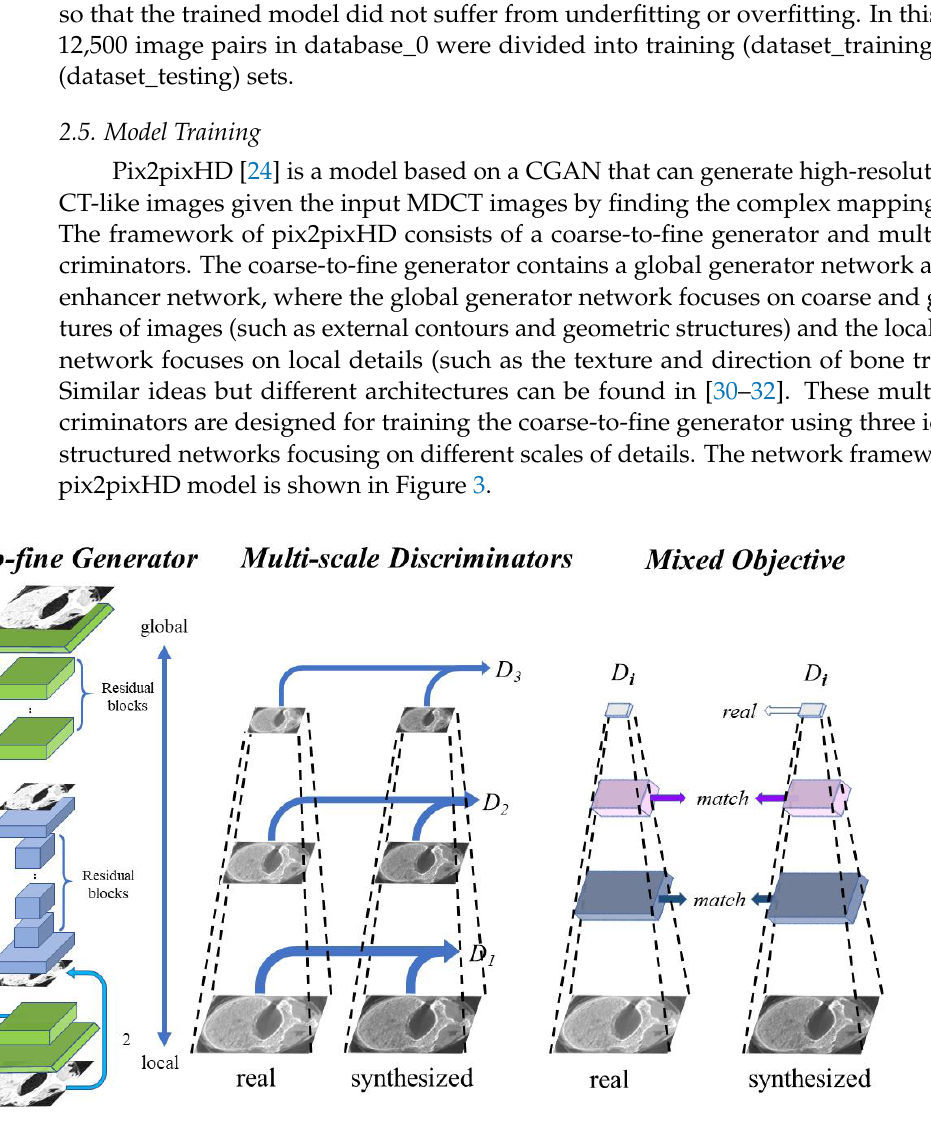
Figure 3. Architecture of the pix2pixHD model used, where the global generator consists of 3 components: a convolution front-end, a set of residual blocks, and a transposed convolutional back-end. The local generator also consists of 3 components: a convolutional front-end, a set of residual blocks, and a transposed convolutional back-end. The multiscale discriminators consist of three identically structured networks.